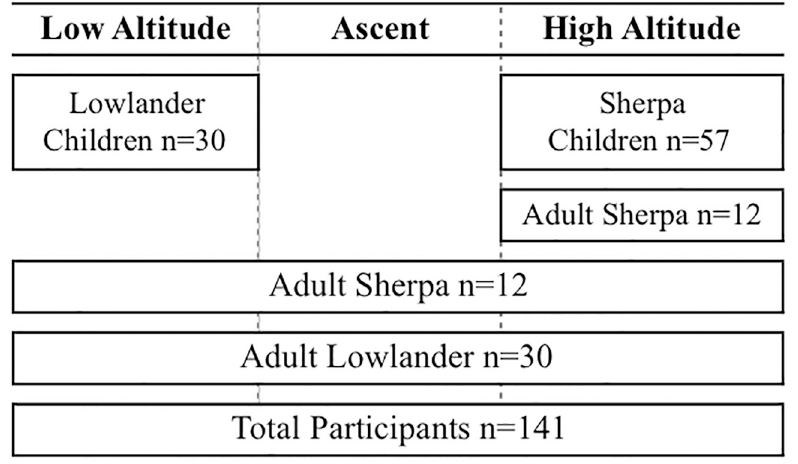
Fig 1. Schematic of sample sizes and location of study